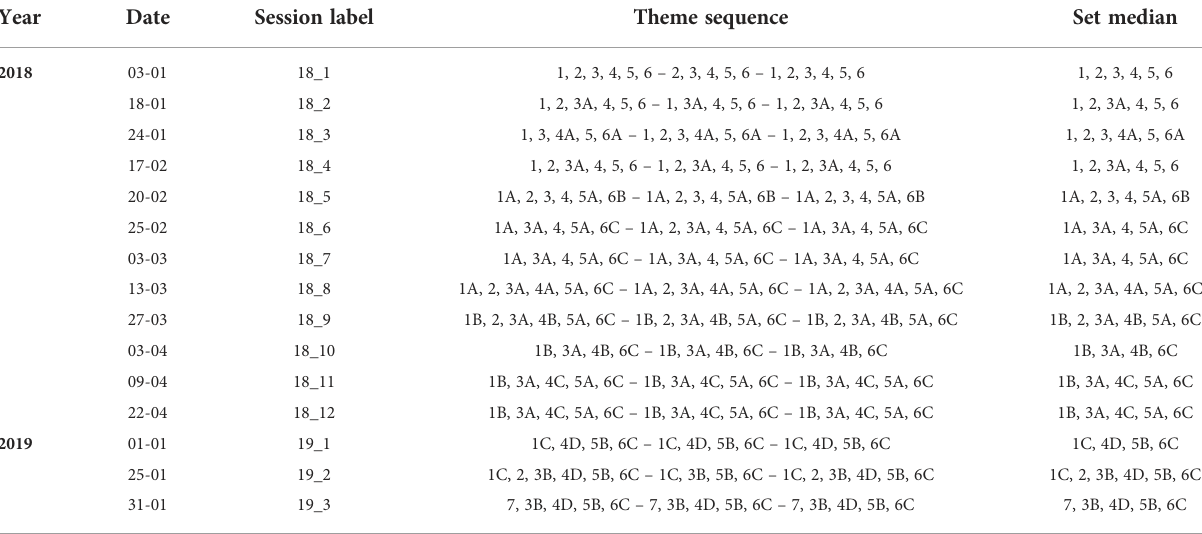
TABLE 3 Transcribed theme sequences of all sessions throughout the study period January 2018 - January 2019. Hyphen ( – ) represent the split between song